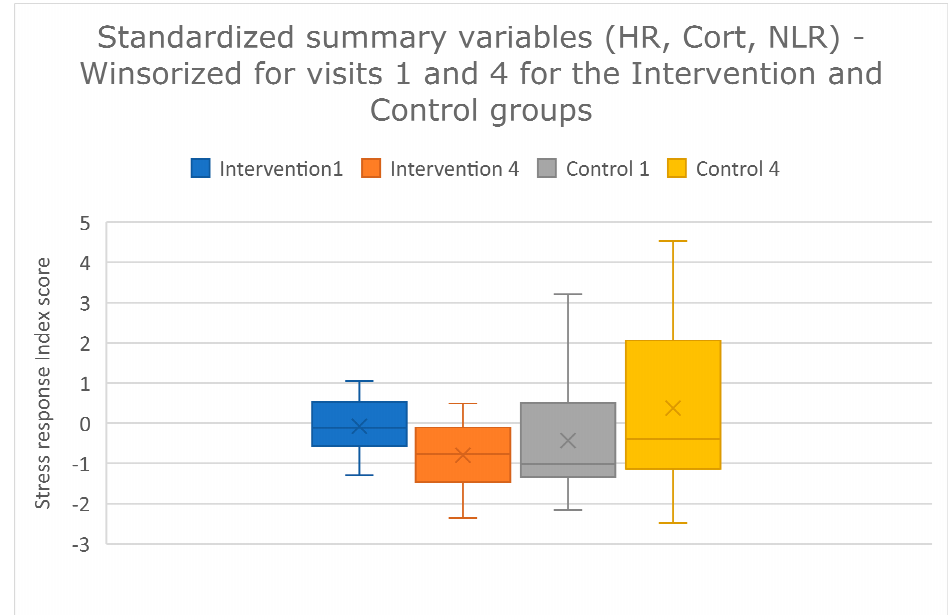
Figure 7. Stress response index score; Summed, standardized measures for HR, CORT and NLR for the first and last visit within the intervention and control groups, as noted in the key on the graph, after data were winsorized. The index score is on the Y axis. Groups are colour-coded by treatment (intervention v. control and visit number (1 v. 4). The box and whisker plots show the means ( × ), the medians (lines), and the values for 75% of index scores (whiskers) for each group.